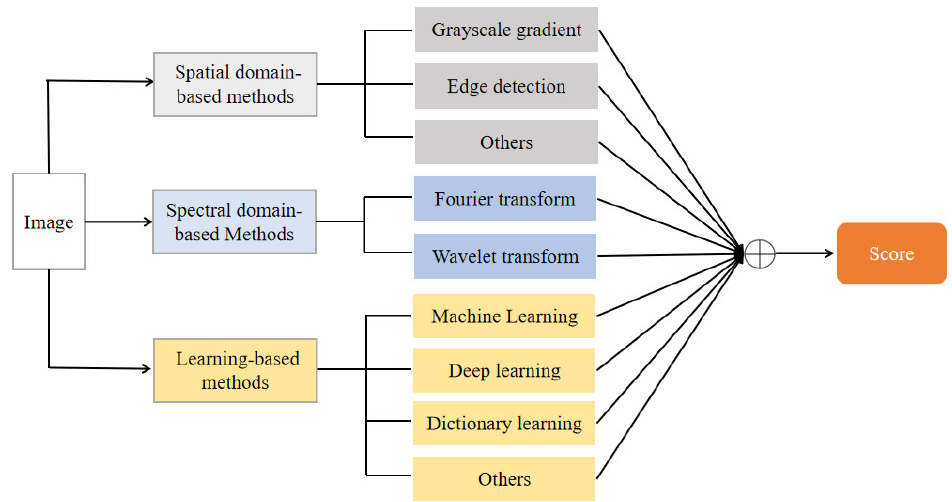
Figure 7. The combined framework of combination methods.